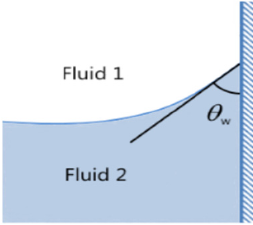
Figure 4. Schematic diagram of the contact angle θ W at the three-phase interface.